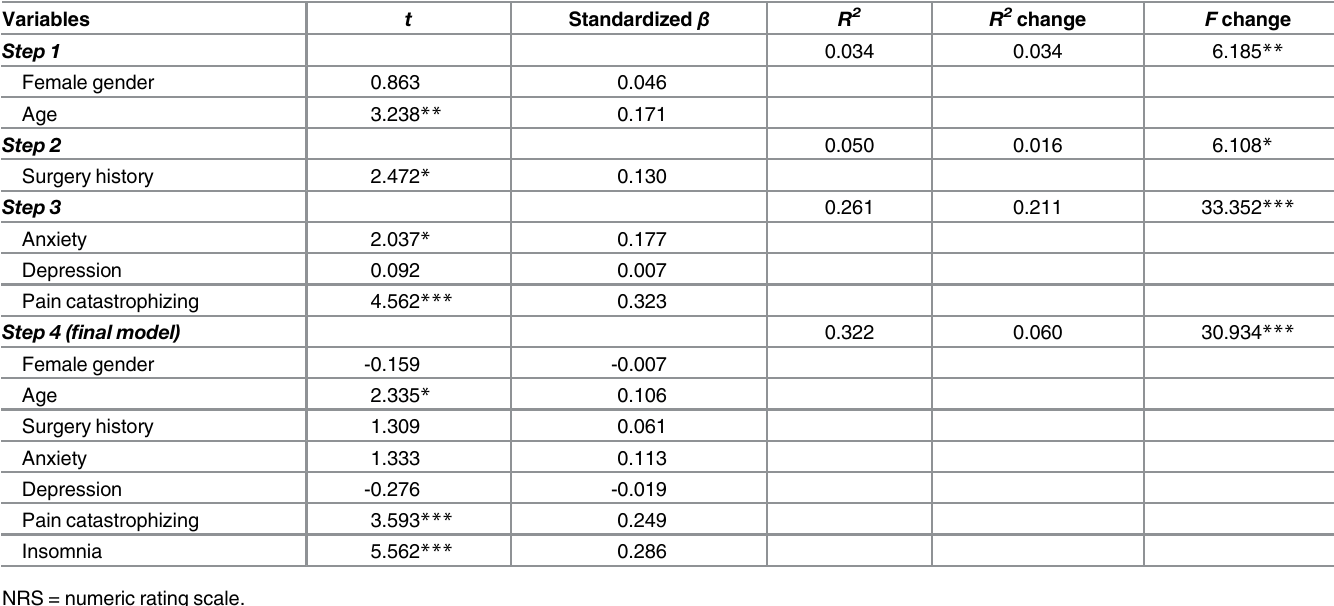
Table 3. Hierarchical linear regression analysis for predictors of pain intensity (0 to 10 NRS) in 357 chronic musculoskeletal pain